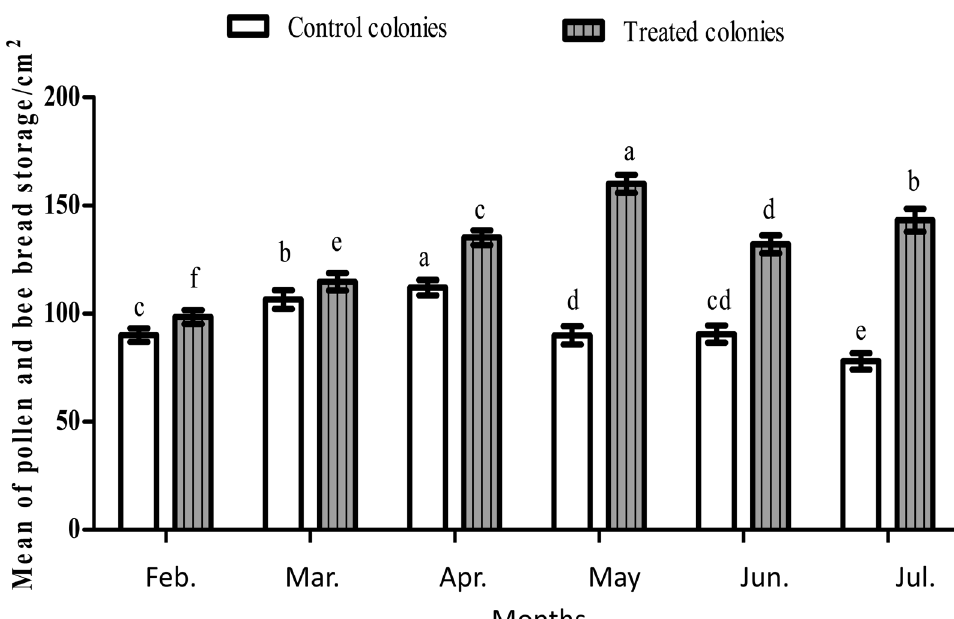
Fig. 4 The average ( SE) of stored pollen and bee bread/cm 2 in control and treated colonies ±